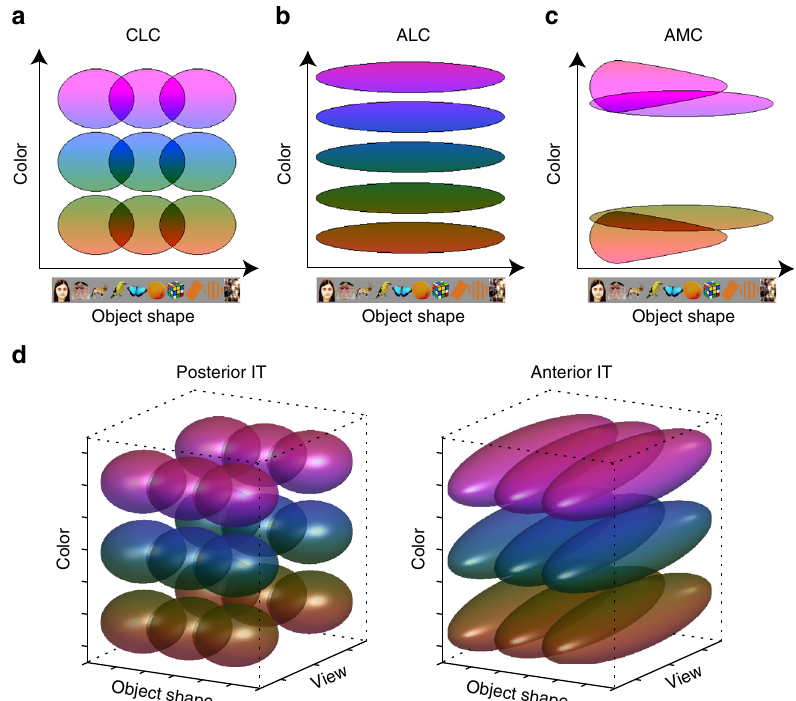
Fig. 8 Extending the conventional view of IT: a theory of color processing in IT. a-c Schematic summary of the co-representation of hue and object shape in three color patches. Here, each oval represents the receptive fi eld of one “ idealized ” color neuron in the 2-d object space spanned by hue and object shape. d Conventional view of IT predicts that the major transformation of colored-object representation from posterior to anterior IT is the generation of invariance to accidental changes (e.g., view). Here each ellipsoid represents the receptive fi eld of one “ idealized ” neuron in the 3-d object space spanned by hue, shape, and view. For both posterior and anterior IT, two dimensional slices at a fi xed “ view ” should look the same as the schematic for CLC ( a presented the grayscale version of the 82 objects to the network to analyze shape representation.